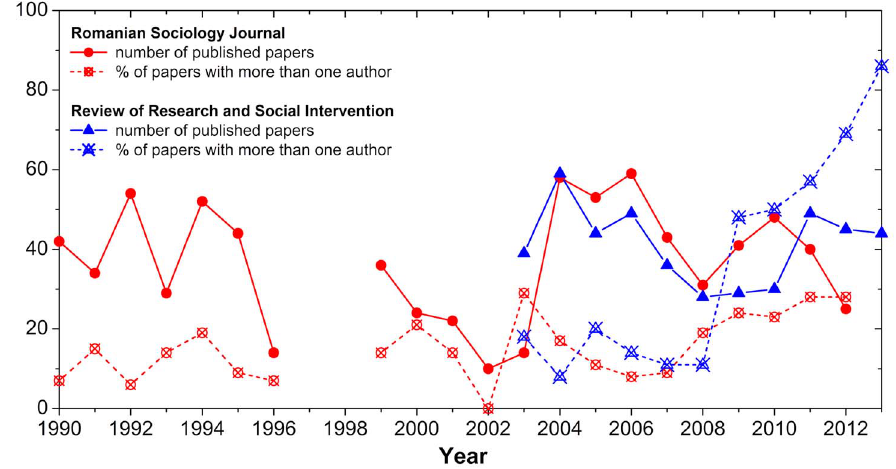
Figure 1. Publishing trends in Romanian sociology. Data is presented for the two main sociology journals that are published in Romania; Romanian Sociology Journal (red) and the Review of Research and Social Intervention (blue). It can be observed that the fraction of papers with more than one author increases over the years, especially for the Review of Research and Social Intervention , while the number of published papers does not display persistent up or down trends. In the years 1997 and 1998 the Romanian Sociology Journal went dormant and therefore data are missing.